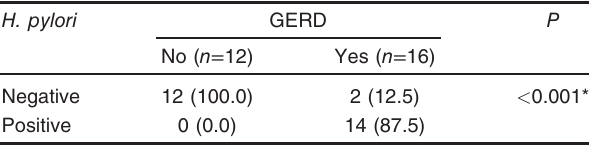
Results are presented as number and percentage. GERD, gastroesophageal reflux disease; H. pylori , Helicobacter pylori